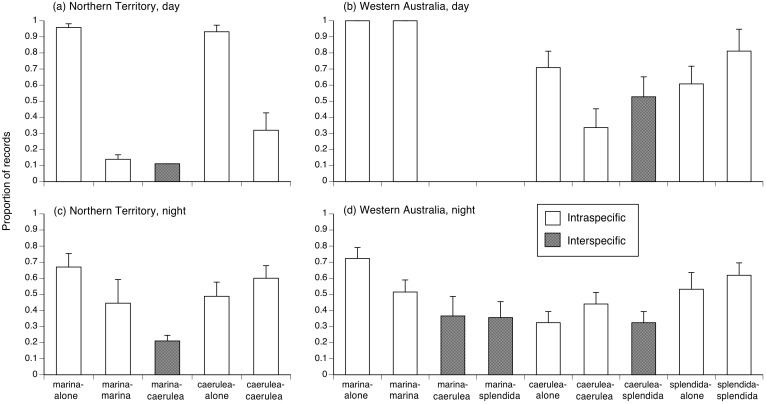
Proportion of encounters of pairs of nearest neighbor species within radio-tracked anurans.caerulea = Litoria caerulea, marina = Rhinella marina, splendida = L. splendida. The panels show data for diurnal habitats in the Northern Territory (a) and Western Australia (b), and for nocturnal habitats in the Northern Territory (c) and Western Australia (d). Graphs show mean values and associated standard errors. Nearest-neighbour pairs that contain two different species are shown in stippled format.